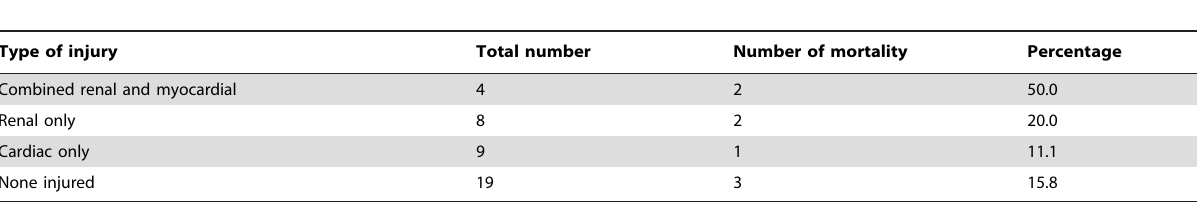
Table 2. Mortality in asphyxiated infants with renal, myocardial, combined renal and myocardial injuries.